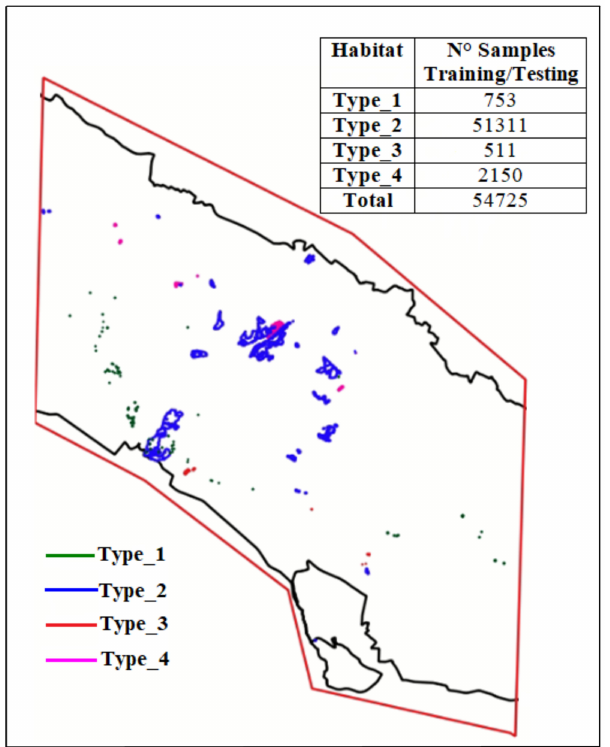
Figure 3. Ground truth samples distribution for individual grassland habitat types over the study